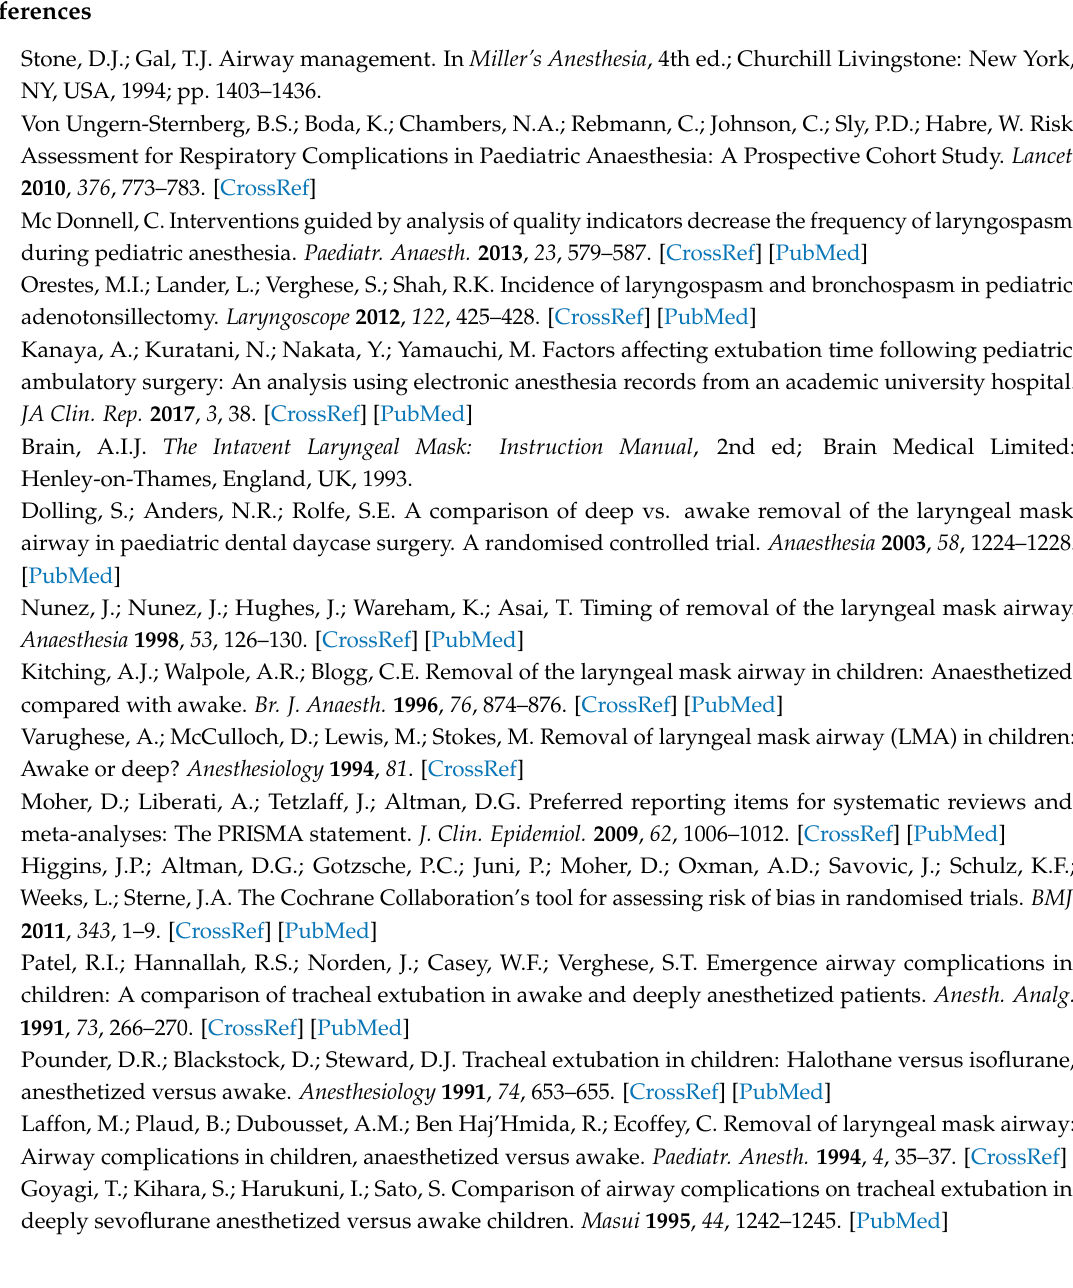
Figure S1: Risk of bias summary, Review author’s judgment about each risk of bias item for each included study; Figure S2: Funnel plot of comparison, deep extubation (experimental) vs. awake extubation (control) outcome: (A) overall complications, (B) airway obstruction, (C) cough, (D) desaturation, (E) laryngospasm, (F) breath-holding; Table S1. Search strategy for each database; Table S2: Details for judgment for each risk of